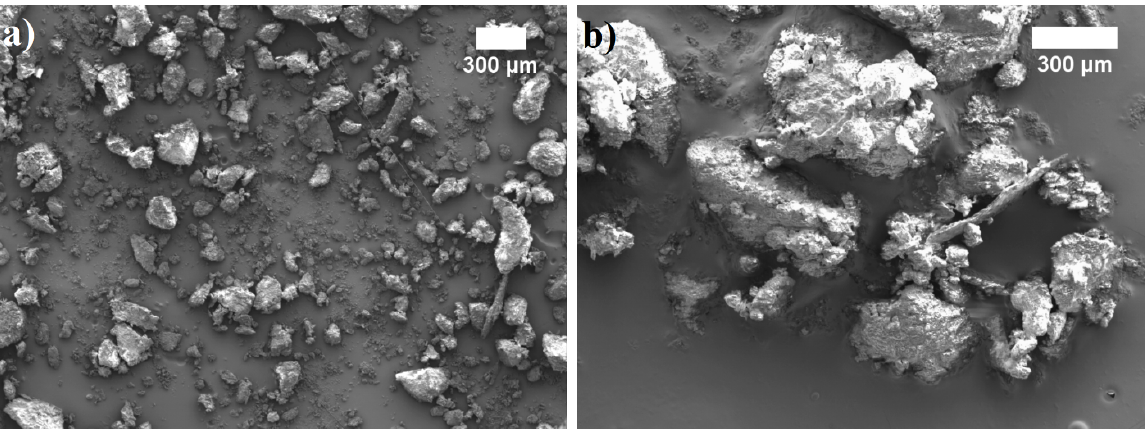
Figure 2. SFP filler: ( a ) at ×40 magnification and ( b ) at ×60 magnification. The moisture content of fillers in PUR foam compositions is of great importance due to the mixture’s sensitivity to water and/or moisture during reaction with isocyanates. The parameter is too important to neglect its impact on foaming and apparent density of the final products. Therefore, the experimental investigation showed that the original mois- ture content of SFP filler particles was 8.4 ± 0.3 wt.% and it confirms the results obtained in other studies [31,32], i.e., up to 11 wt.%. However, after the thermal treatment at 110